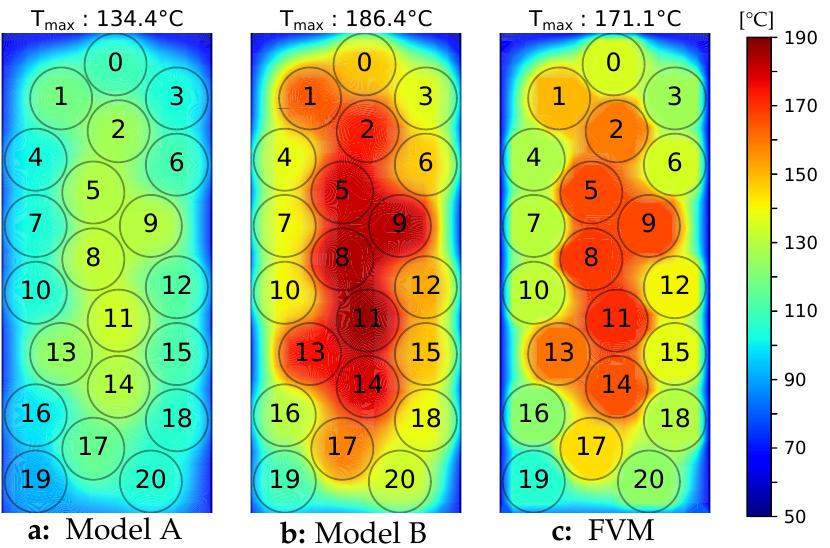
Figure A2. Comparison of thermal contours for rectangular shape with a random layout between method A ( a ), method B ( b ) and FVM ( c ). Results data from Table